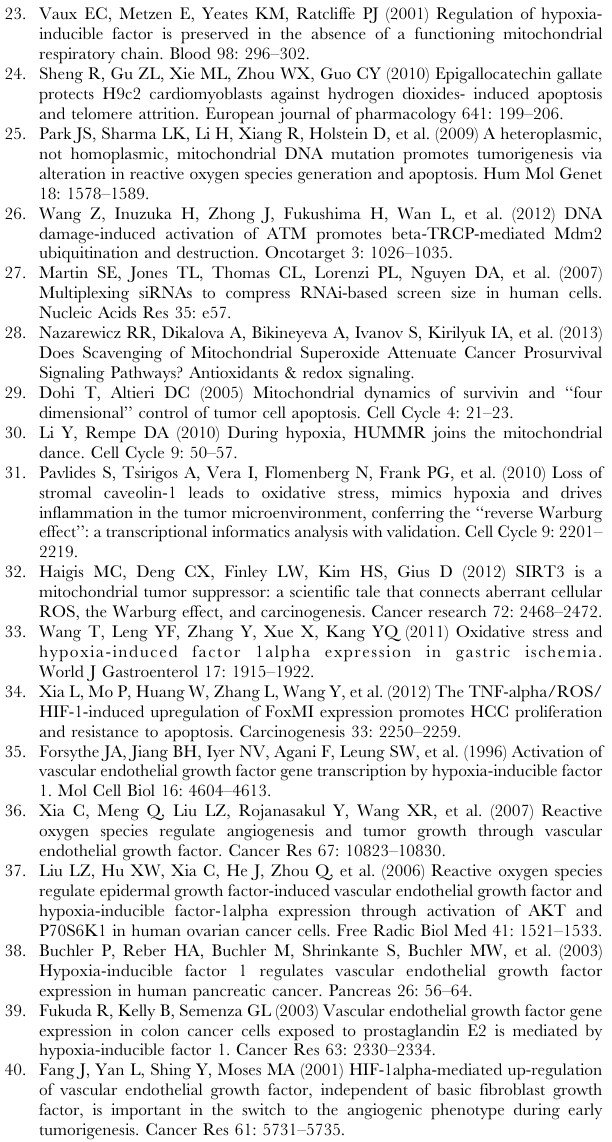
Figure S2 Effect of ROS on migration and invasion capacity of subclones and their parental cells by transwell assay. A, The invasive capacity of SKBR3 subclones was higher than the parental SKBR3 cells and was effectively inhibited by NAC. B, The invasive capacity of 4T1 subclones was NAC. Figure S3 PEG-catalase and mito-TEMPO inhibited migration and invasion in C subclone cells. A, The migration capacity of C subclone cells treated with different